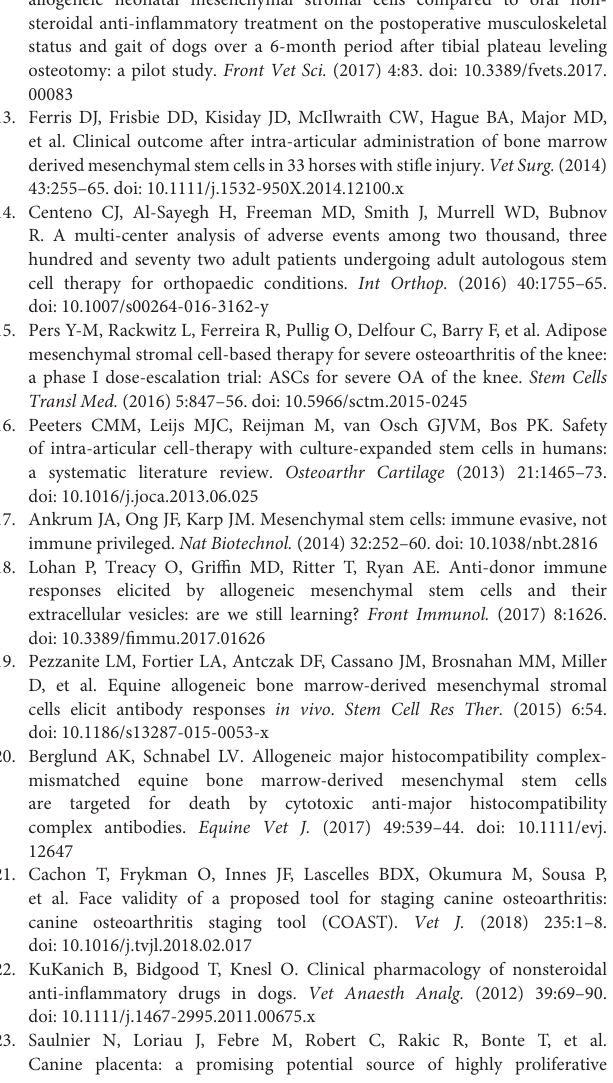
Supplementary Table 1 | Parameters used to grade joint OA and scale (0–4) of evaluation. Supplementary Table 2 | Details of the dogs re-engaged for 6months follow-up after a second injection in a same member. Supplementary Figure 1 | Effect of IFN- γ on Major Histocompatibility Complex (MHC) molecule and indoleamine 2,3-dioxygenase (IDO) expression in canine